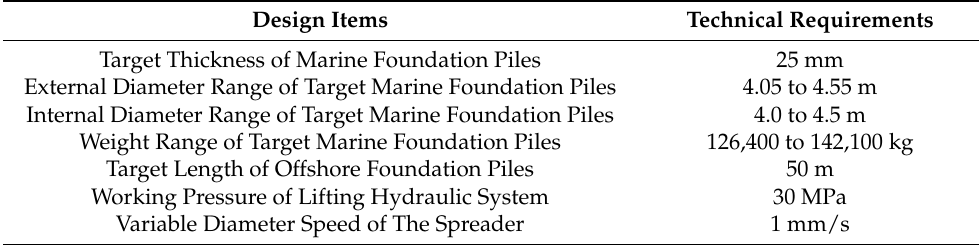
Table 5. Technical Requirements for the Internal and External Clamping Type Marine Pile